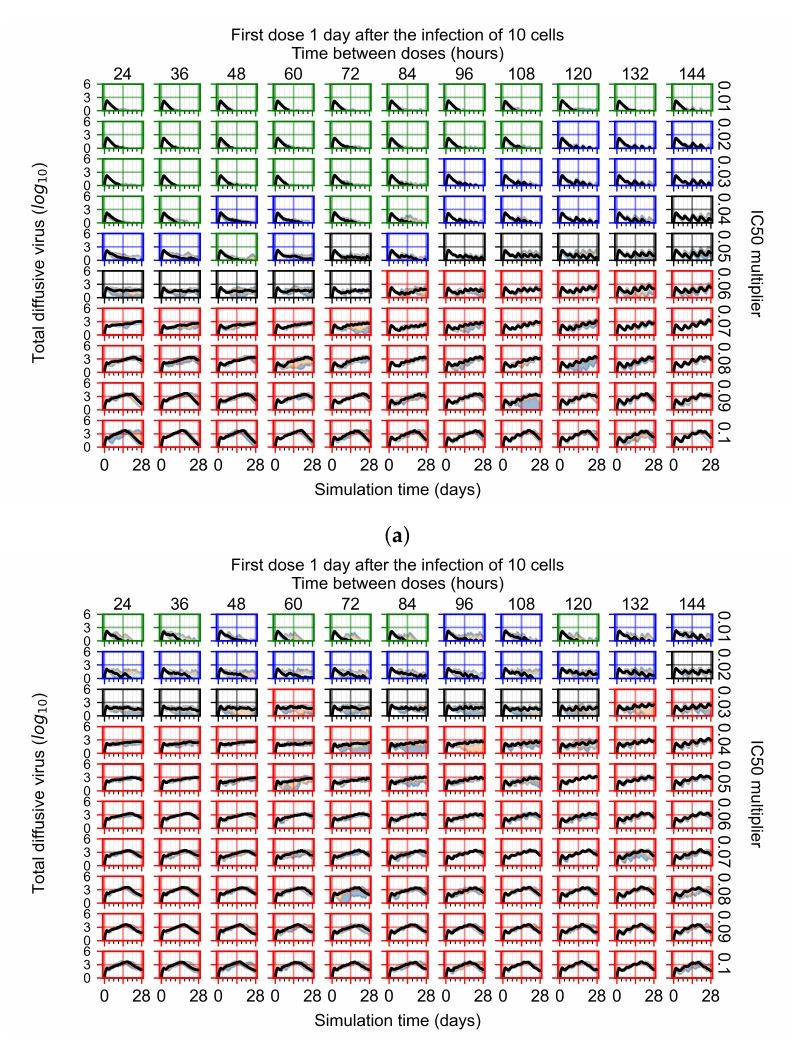
Figure 13. Extracellular diffusive virus populations for eight replicas of the treatment simulation. Epithelial cells’ metabolism and clearance varies from cell to cell. For all subfigures, the median measurement of simulation replicas is the black line, the 0th to 100th quantiles are shaded as dark blue, 10th to 90th shaded in orange, and 25th to 75th as light blue. Rapid clearance plot axis in green, slow clearance plot axis in blue, partial containment in black, and widespread infection in red. ( a ) Cells’ metabolism standard deviation set to 0.1. ( b ) Cells’ metabolism standard deviation set to